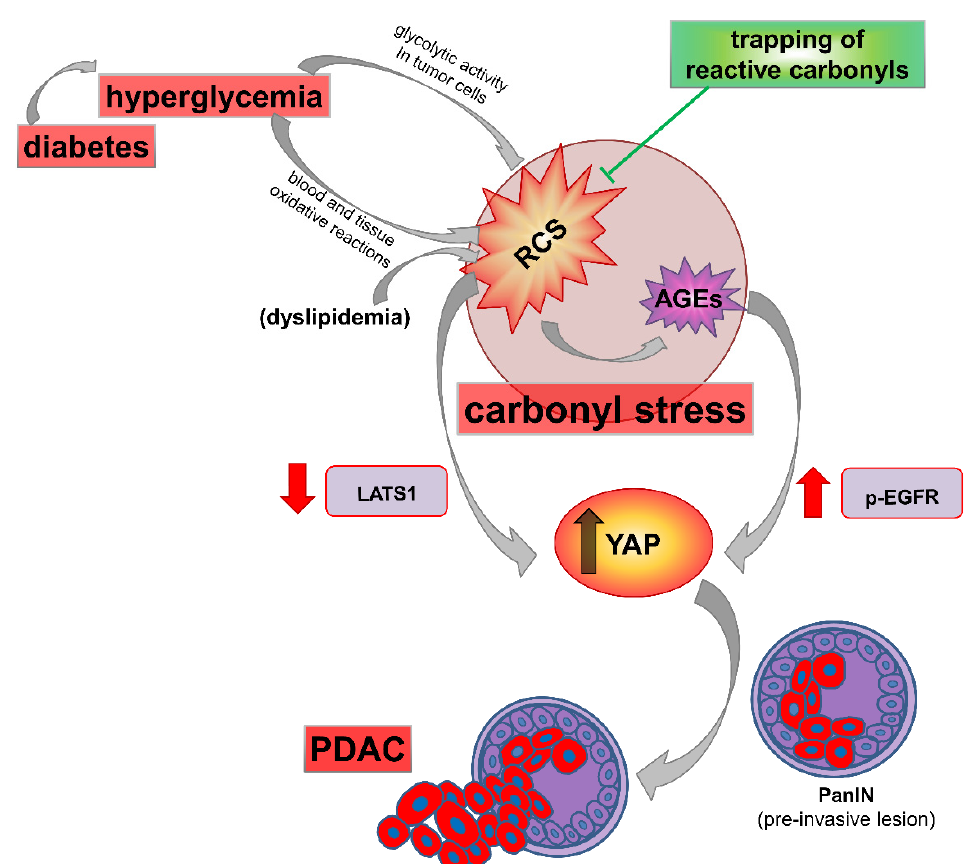
Figure 6. Carbonyl stress in pancreatic ductal adenocarcinoma (PDAC) promotion induced by diabetes, and mechanism of protection by reactive carbonyl species (RCS) trapping agents. Diabetes markedly accelerates tumor progression through hyperglycemia-derived carbonyl stress. The increased availability of glucose feeds the glycolytic flux of tumor cells favoring local formation of RCS such as methylglyoxal, which represent an inevitable side-product of glycolysis. In addition, circulating RCS and advanced glycation end-products (AGEs) derived from non-enzymatic glycoxidation (and lipoxidation) reactions occurring at the systemic level may also contribute to the overall burden of carbonyl stress in neoplastic lesions. Increased RCS and AGE levels in PDAC cells has been associated with increased nuclear translocation of Yes-associated protein (YAP), a key effector of Hippo pathway and regulator of tumor growth and invasion. Dyslipidemia, associated or not with hyperglycemia, may represent an additional source of RCS and AGEs. Sequestering of RCS and consequent inhibition of AGE formation efficiently prevented hyperglycemia-induced YAP activation and acceleration of pancreatic intraepithelial neoplasia (PanIN) progression to invasive cancer in a mouse model of Kras-driven PDAC, through inhibition of large tumor suppressor kinase 1 (LATS1) and phosphorylation of epidermal growth factor receptor (p-EGFR), respectively.